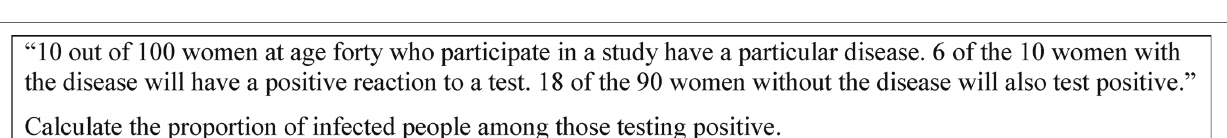
FIGURE 1 | A medical context of judgment and decision making under uncertainty.